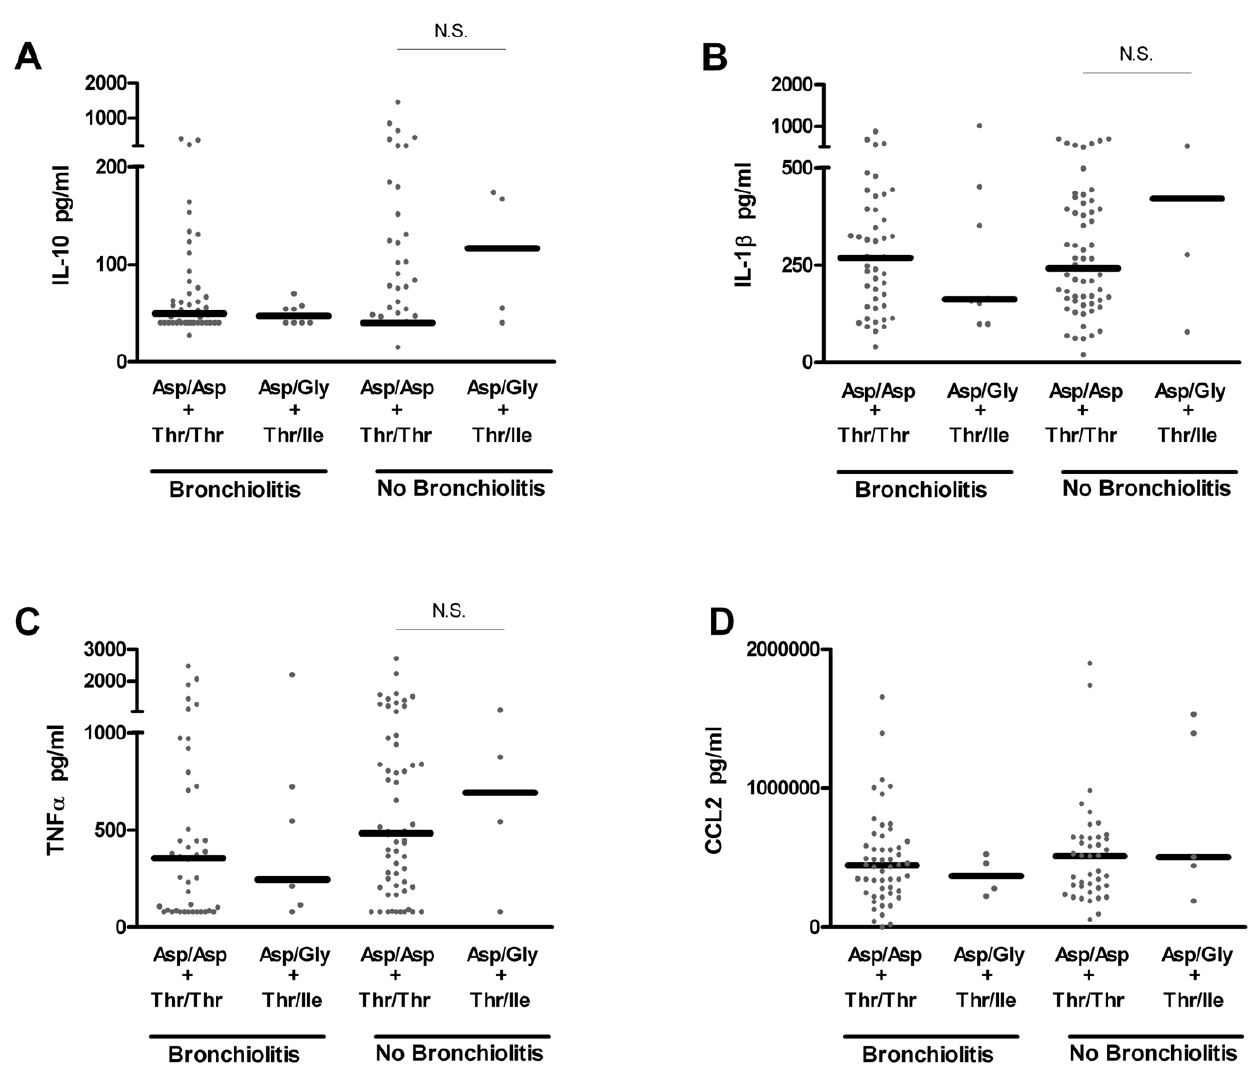
Figure 3. Similar LPS-driven cytokine responses exhibited by children with the homozygous (Asp/Asp + Thr/Thr) and heterozygous (Asp/Gly + Thr/Ile) TLR4 haplotypes with or without prior bronchiolitis. All comparisons yield P . 0.05.